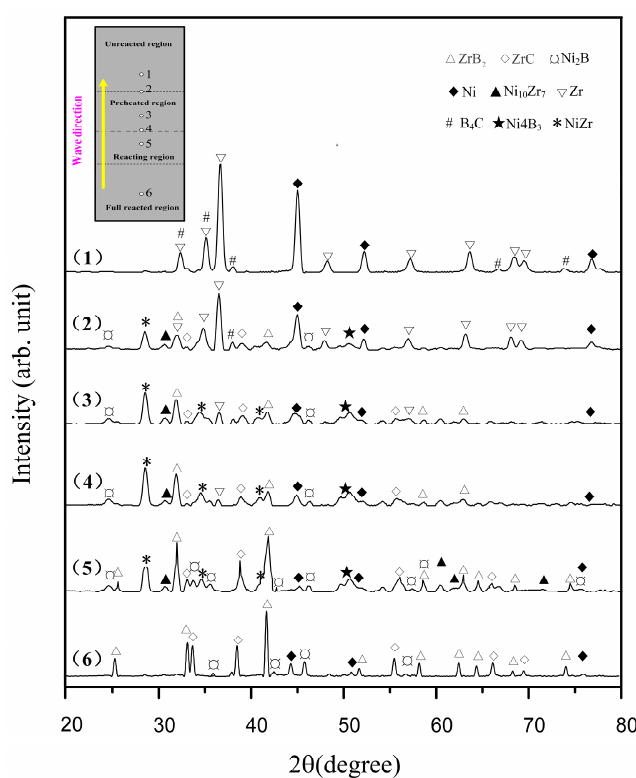
Figure 10. X-ray micro-diffraction patterns in different regions of the SHS quenched bar: (1) unreacted region, (2) preheated region, (3–5) reacting region, and (6) fully reacted region, respectively.